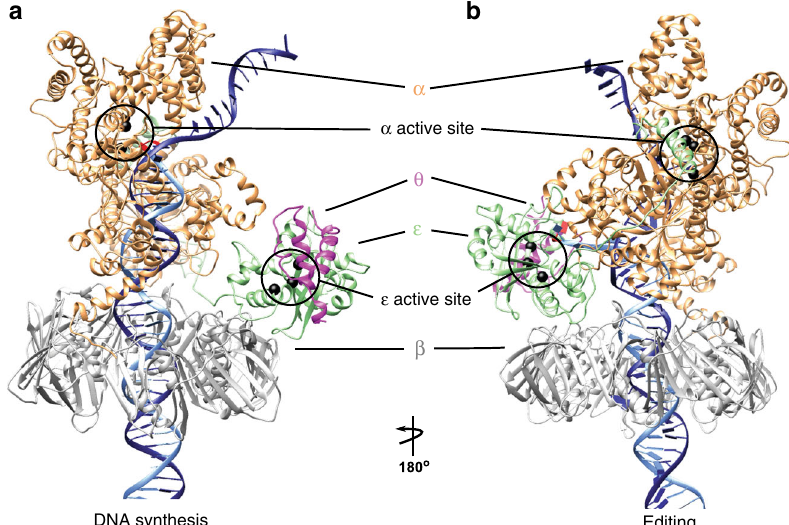
Fig. 1 Structural models of DNA polymerase III in polymerization and editing mode. The Pol III core ( α , ε , and θ ) bound to the DNA sliding clamp β in ( a ) polymerization mode and ( b ) editing mode. Pol III subunits are colored and labeled as follows: α in orange, ε in green, θ in magenta, and β in gray. The primer and template DNA strands are shown in light and dark gray respectively. The polymerase active site (in the α subunit) and exonuclease active site (in the ε subunit) are highlighted with